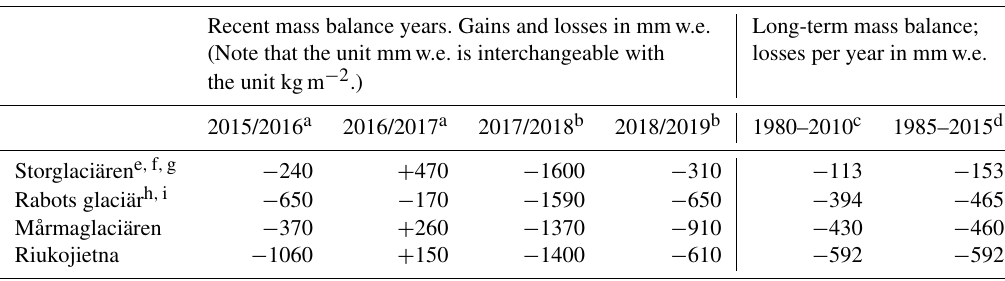
Table 11. Mass balances for the Swedish glaciers Storglaciären, Rabots glaciär, Mårmaglaciären, and Riukojietna. General references are given as footnotes in connection with balance years and long-term monitoring intervals, respectively. Selected specific references are given as footnotes in connection with the glacier names and also include the neighbouring glaciers, Kårsa and Kebnepakte. Data source: SITES data portal at https://data.fieldsites.se/portal/ (last access: 10 February 2022); World Glacier Monitoring Service, 2021; Swedish Infrastructure for Ecosystem Science, 2021a, b, c). Recent mass balance years. Gains and losses in mmw.e. Long-term mass balance; (Note that the unit mmw.e. is interchangeable with losses per year in mmw.e. the unit kgm − 2 .)